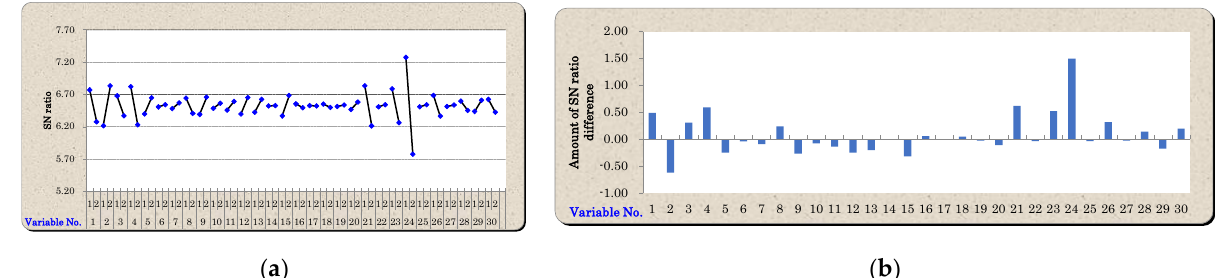
Figure 9. ( a ) SNR Plot and ( b ) SNR Gain Chart for Wdbc dataset.